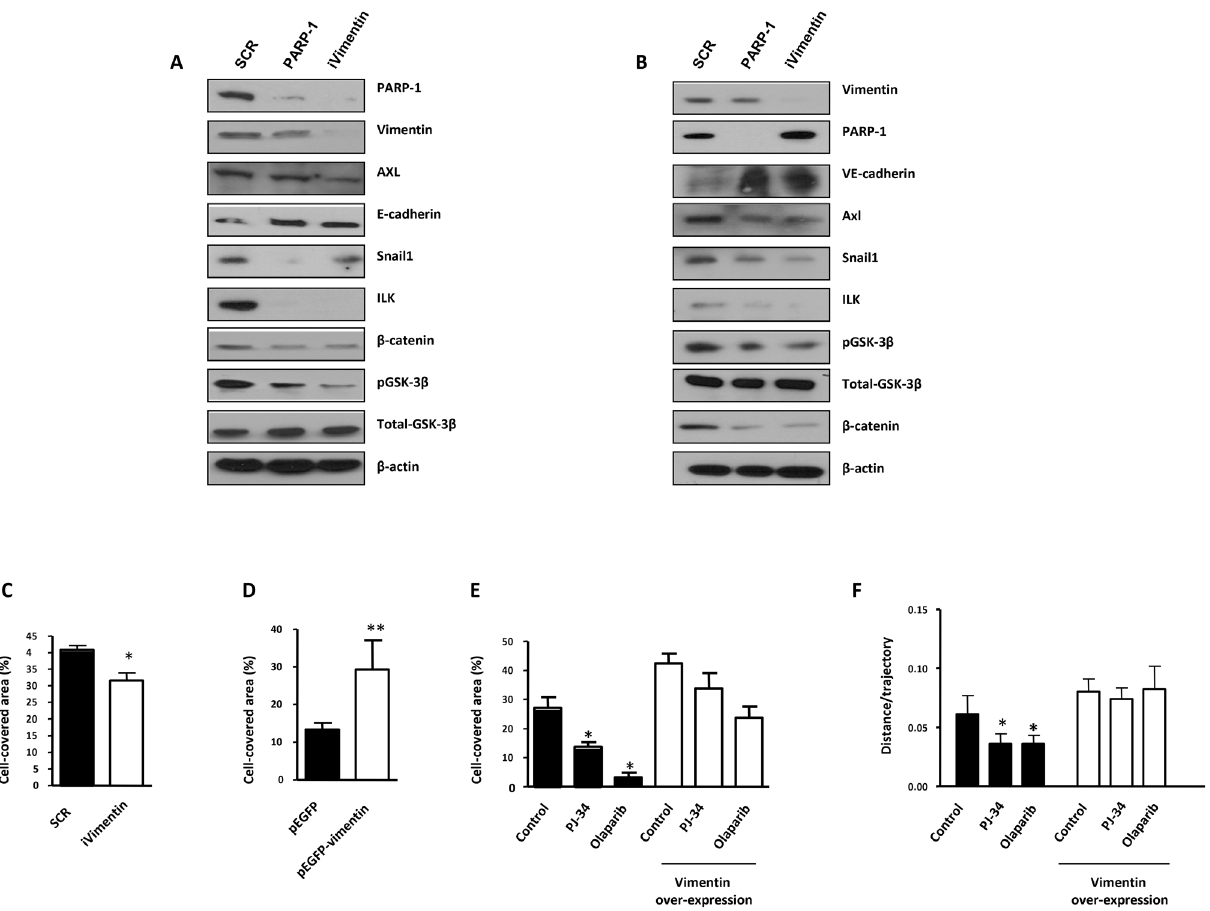
Figure 4. PARP-1 or vimentin is sufficient to reverse EMT and confer increased cell motility. ( A ) Melanoma (G361) and endothelial (HUVEC) ( B ) cells were silenced for PARP-1 or vimentin and the expression levels of Axl, E-/VE-cadherin, Snail1, ILK, b -catenin, GSK-3 b , PARP-1, and vimentin were determined by immunoblot. ( C ) HUVEC were silenced for vimentin and wound healing was measured. After over-expression of vimentin wound healing closure was measured in HUVEC cells ( D ) or B16-F10 ( E ). ( F ) Cell migration was analyzed in epithelial cell line Madin Darby canine kidney (MDCK) cells transfected with either GFP or GFP-vimentin using video-microscopy and MetaMorph Image Analysis software. While vimentin was able to increase the length of the trajectories in the absence or presence of hepatocyte growth factor (HGF), treatment with PARP inhibitor resulted in a sustained reduction in cell motility (* P , 0.05 PJ-34 or olaparib versus control).